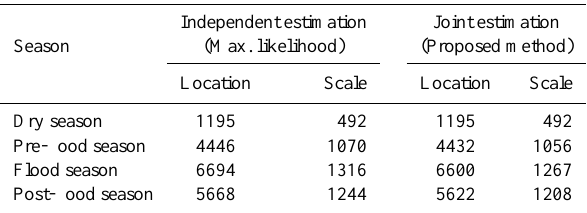
Table 2. Parameters of the seasonal distributions [m 3 s − 1 ]: inde- pendent fitting (maximum likelihood estimation) and joint estima- tion by adopting uniform weights (proposed